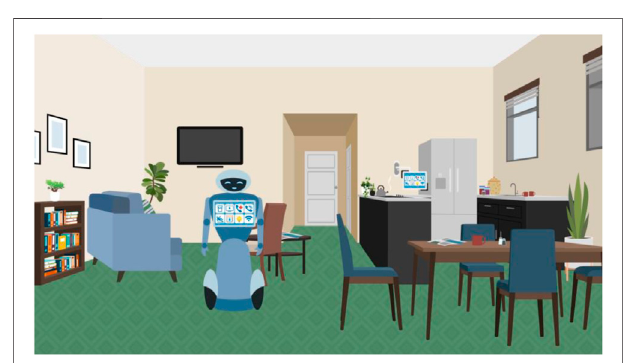
FIGURE 3 | Illustration used in VWT role-play interview showing the interior of the neighbour ’ s fl at.